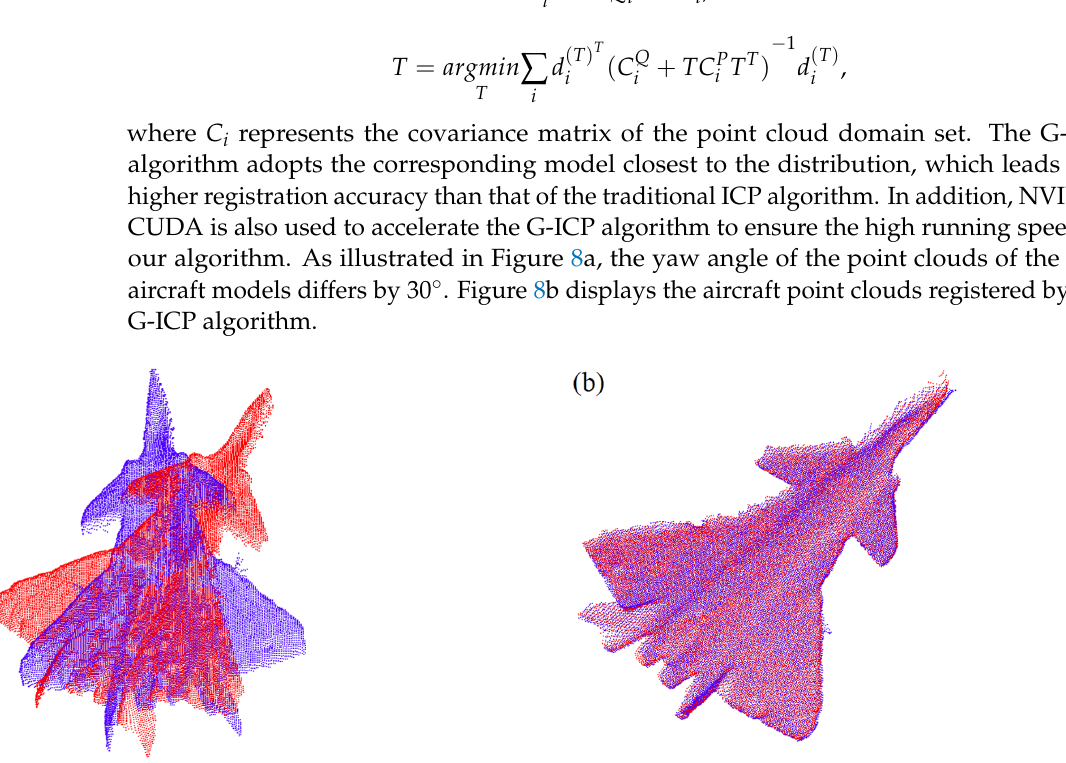
Figure 8. ( a ) Aircraft point cloud before registration; ( b ) aircraft point cloud after registration.